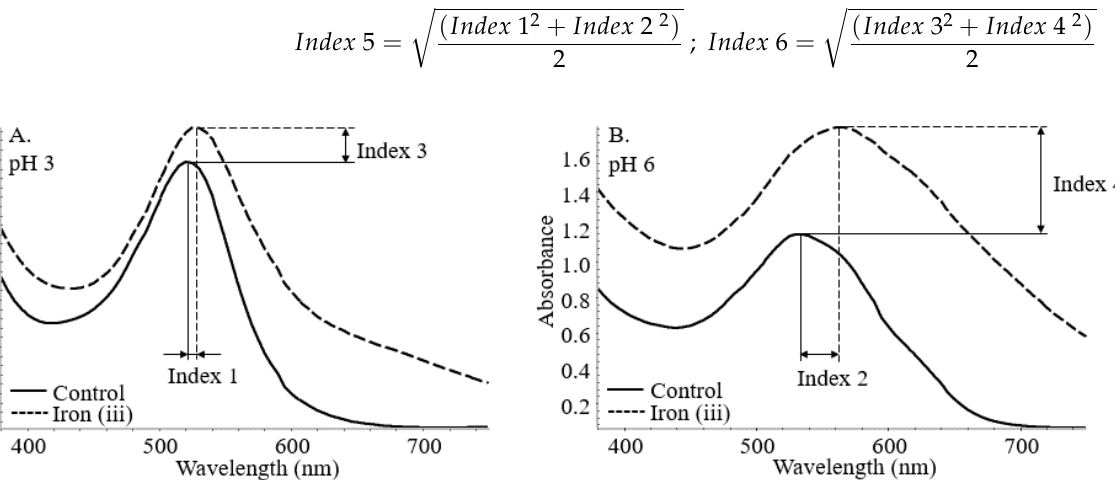
Figure 2. Bathochromic (Index 1 ( A ) and 2 ( B )) and hyperchromic (Index 3 ( A ) and 4 ( B )) shifts of co-pigmented anthocyanin measured by UV–vis